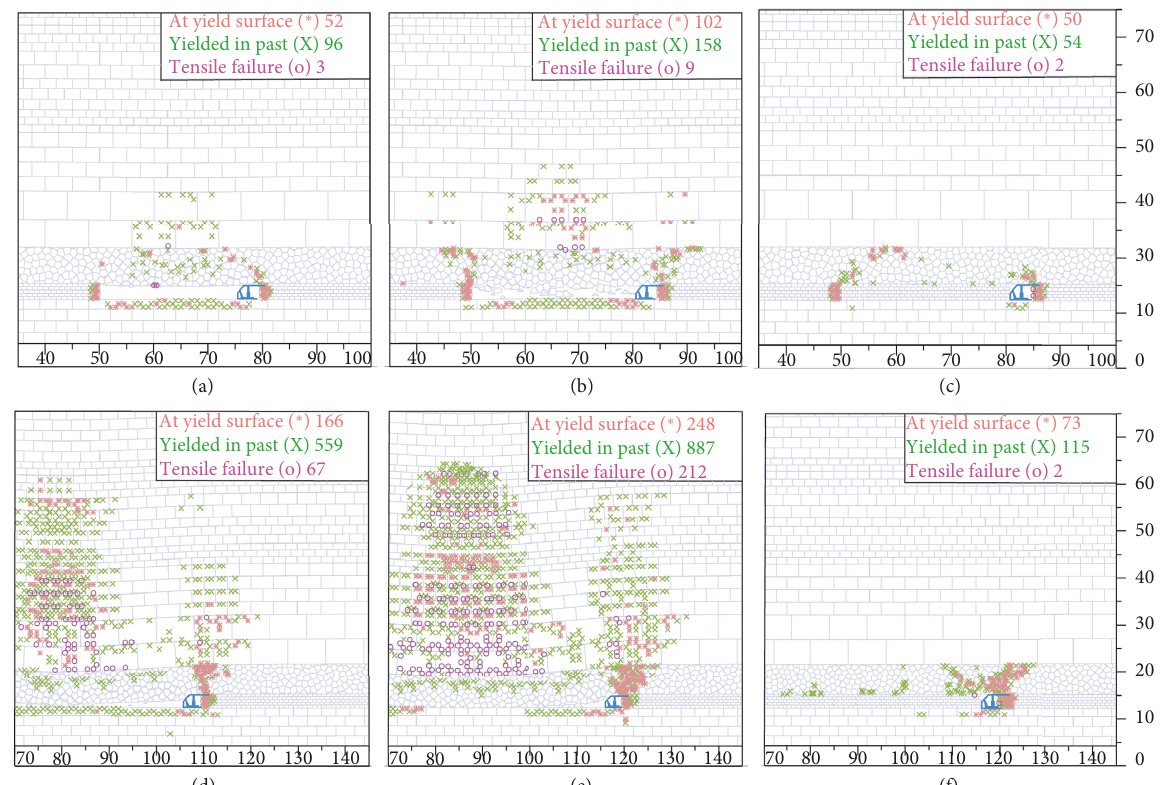
Figure 6: Plastic zones development in different roof management methods. (a) Nonbackfilling excavation 30m. (b) Nonbackfilling excavation 35 m. (c) Backfilling excavation 35m. (d) Nonbackfilling excavation 60m. (e) Nonbackfilling excavation 70m. (f) Backfilling excavation